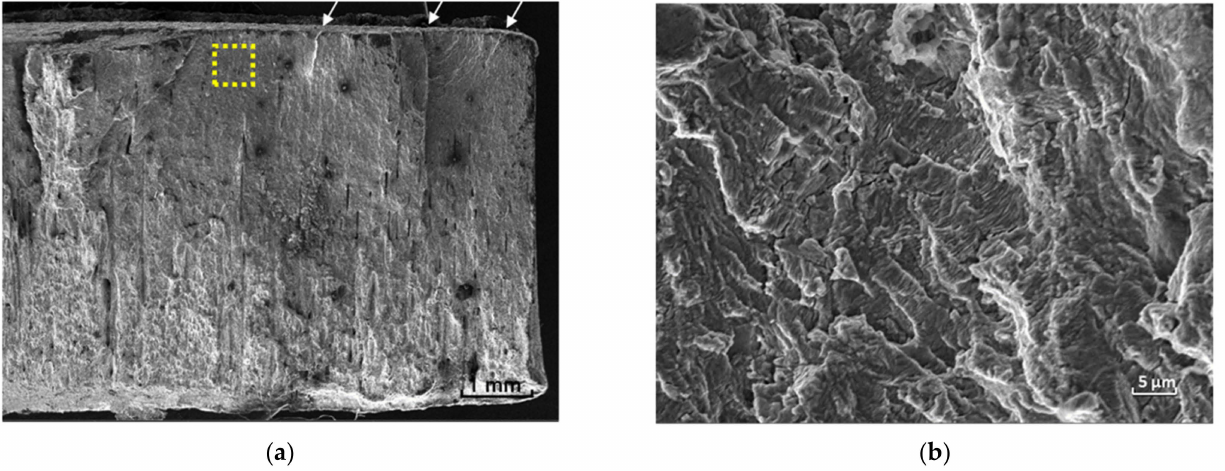
Figure 10. ( a ) Representative SEM image of the coated specimen fracture. The ratchet marks (some of them are highlighted by arrows) at the top of figure indicate fatigue nucleation sites. Crack propagation is identified by the smooth surface preceding the final fracture. ( b ) Fatigue striations perceived on the region highlighted in ( a